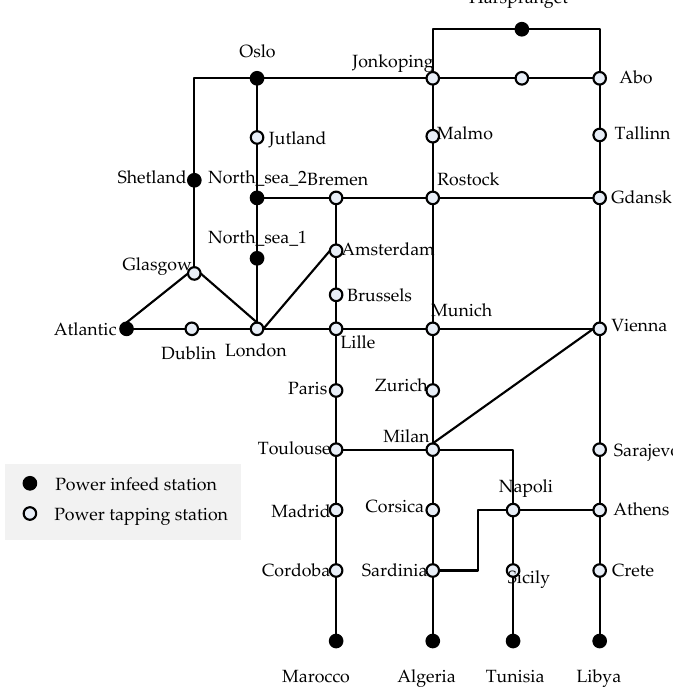
Figure 12. Single-line diagram of Continental Overlay HVDC Grid (40 buses).